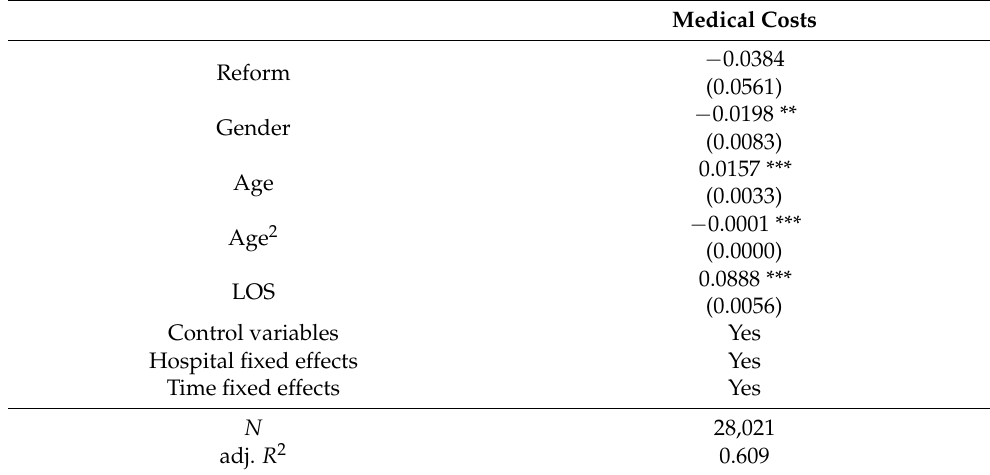
Table A1. Placebo tests of the effects on medical